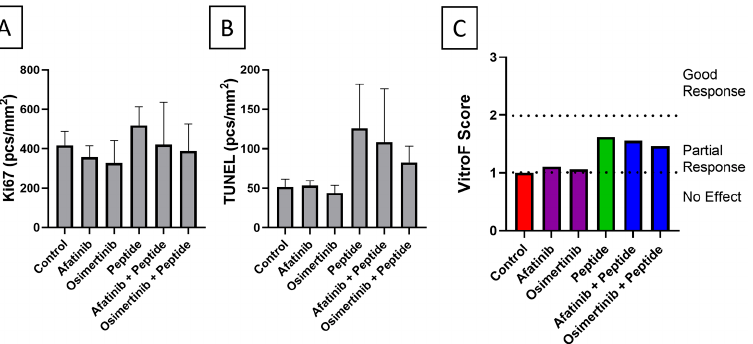
Figure 2. Quantification of ex vivo response of tissue explants of Patient #2 for single and com- binatorial treatment of afatinib, osimertinib and R11-NLS-Pep8. Graphs (mean ± SEM) showing quantification of ( A ) Ki67 and ( B ) TUNEL positive cells of control and treated explants, expressed as frequency (pcs/mm2). ( C ) VitroF score of the treatments.